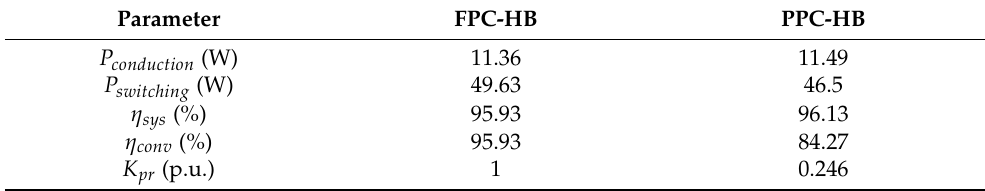
Table 8. Experimental power loss, efficiency, and 𝐾 (cid:3043)(cid:3045) results obtained with the single-inductor to- pology.